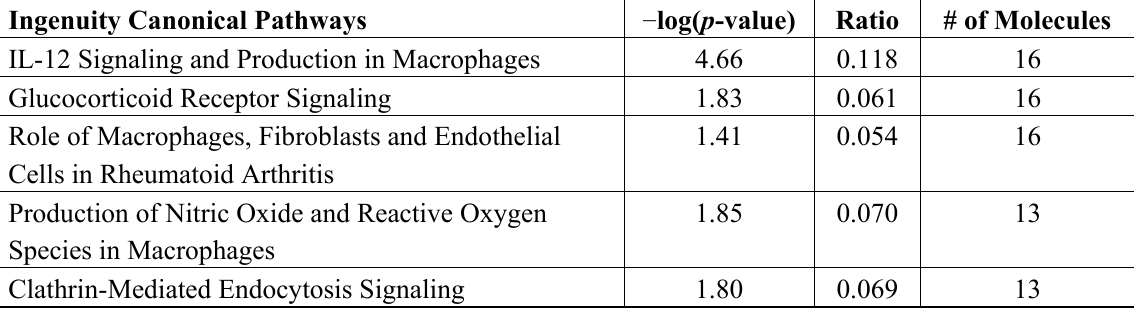
Table 1. Significant canonical pathways at 0 h post-heat exposure. Two-hundred seventy-four Ingenuity Canonical Pathways were scored at 0 h post-heat exposure; only the 33 listed pathways fit the cut-off of p -value ≤